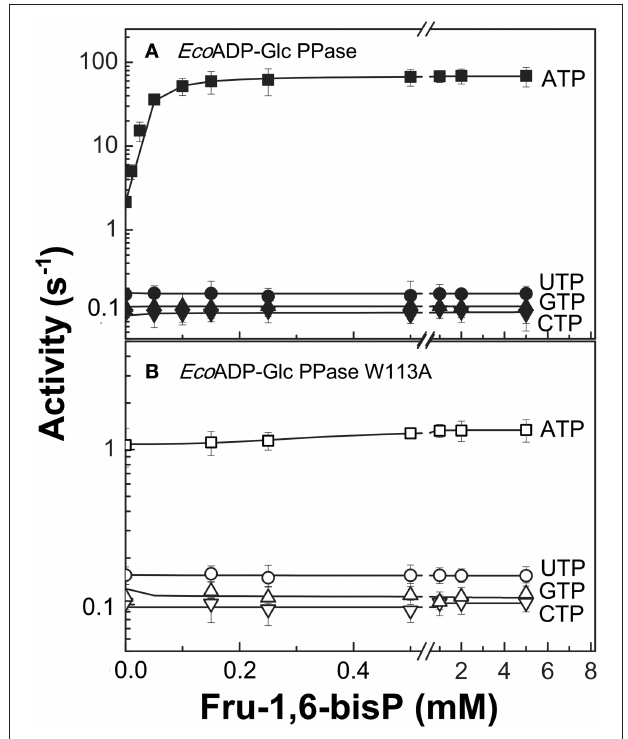
FIGURE 1 | Nucleotide dependent effect of Fru-1,6-bisP on ADP-Glc PPase activation. Activity of (A) E. coli ADP-Glc PPase wild type and (B) W113A mutant with alternative nucleotide (2 mM) as substrates. Error bars are SD of three independent sets of data.